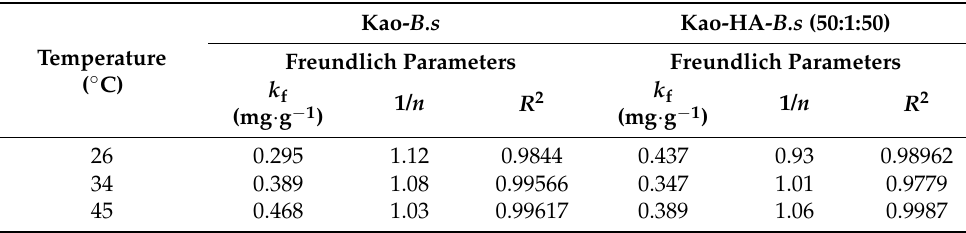
Table 2. Parameters for As(V) adsorption on Kao- B.s and Kao-HA- B.s systems by Freundlich isotherm models.